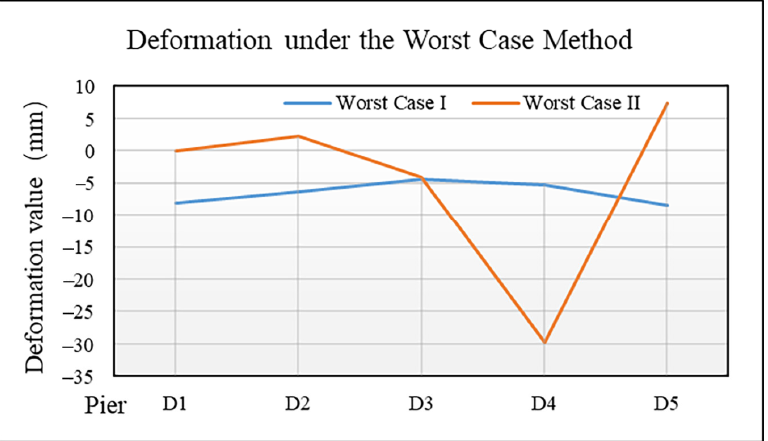
differential deformation between piers D 3 and D 4 .